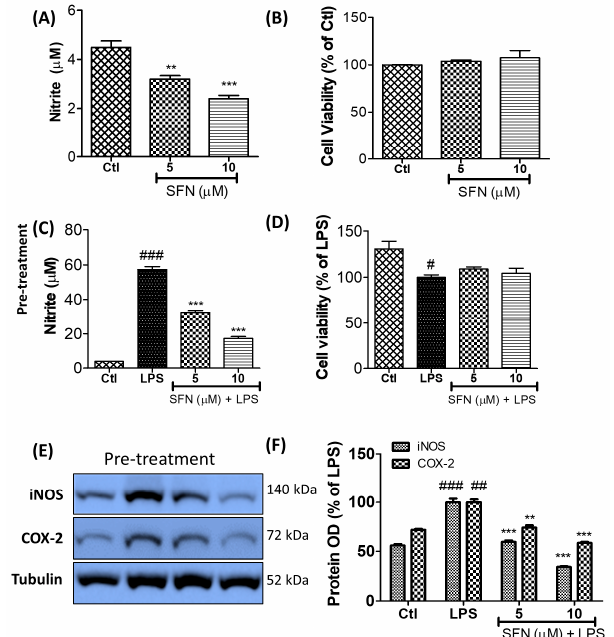
differences compared with the untreated control group. Ctl—untreated control cells; LPS—cells treated with lipopolysaccharide